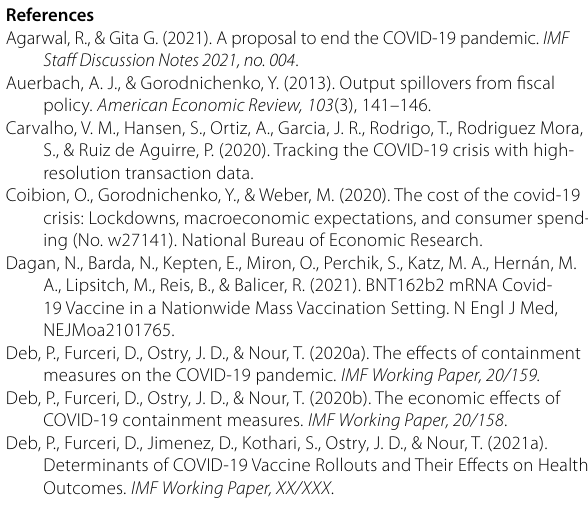
country specific time trends, as well as country and time fixed effects. Standard errors are clustered at the country level. *** p < 0.01, ** p < 0.05, * p <